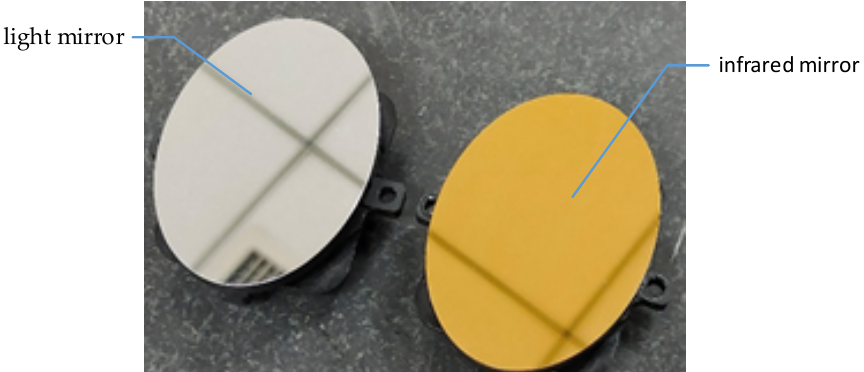
Figure 8. Physical objects of the visible light mirror and infrared mirror. The results of the surface roughness test of the visible light mirror (before plating the reflection film) are shown in Table 3. A total of 16 subregions were measured. They showed that the surface roughness of the visible light mirror was greater than 3